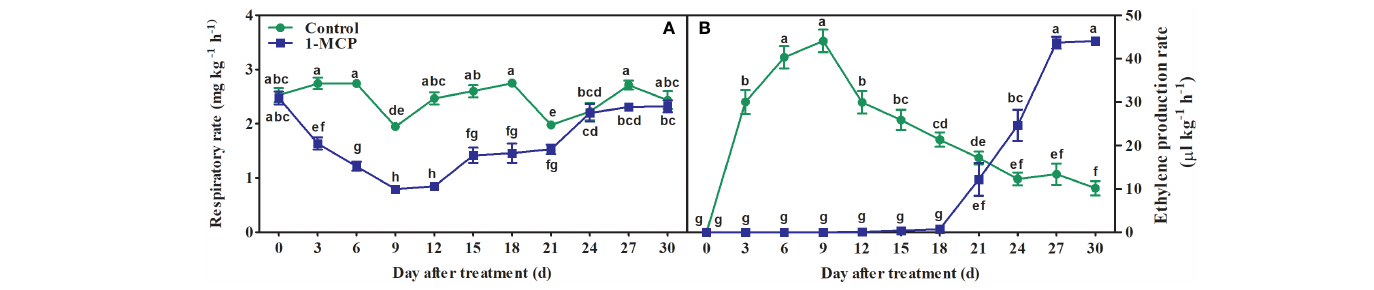
FIGURE 2 Effects of 1-MCP treatment on rates of (A) respiration and (B) ethylene production in ‘ Yuluxiang ’ pear during storage. Data are mean ± SE ( n = 3); values labeled with different letters represent a signi fi cant difference at p